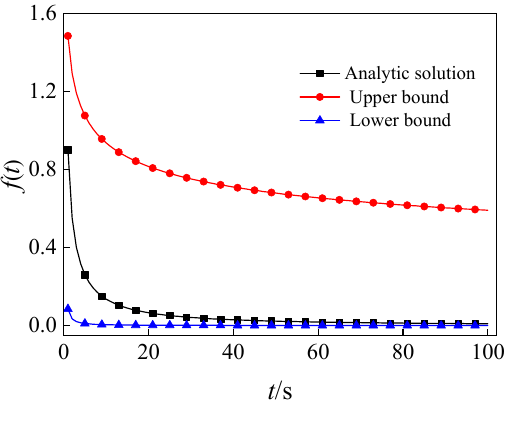
Figure 5. Characteristics of f ( t ).